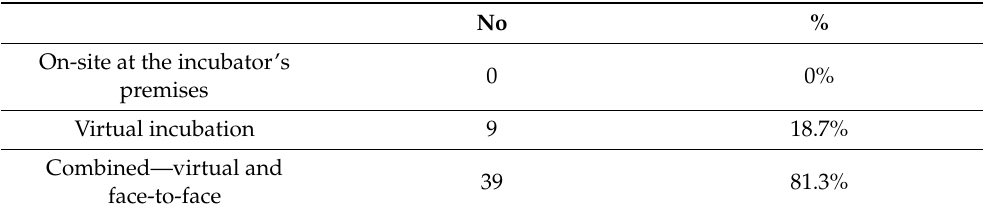
Table 4. The location of respondents at the time of incubation, percentage of respondents ( n = 48) (source: authors’